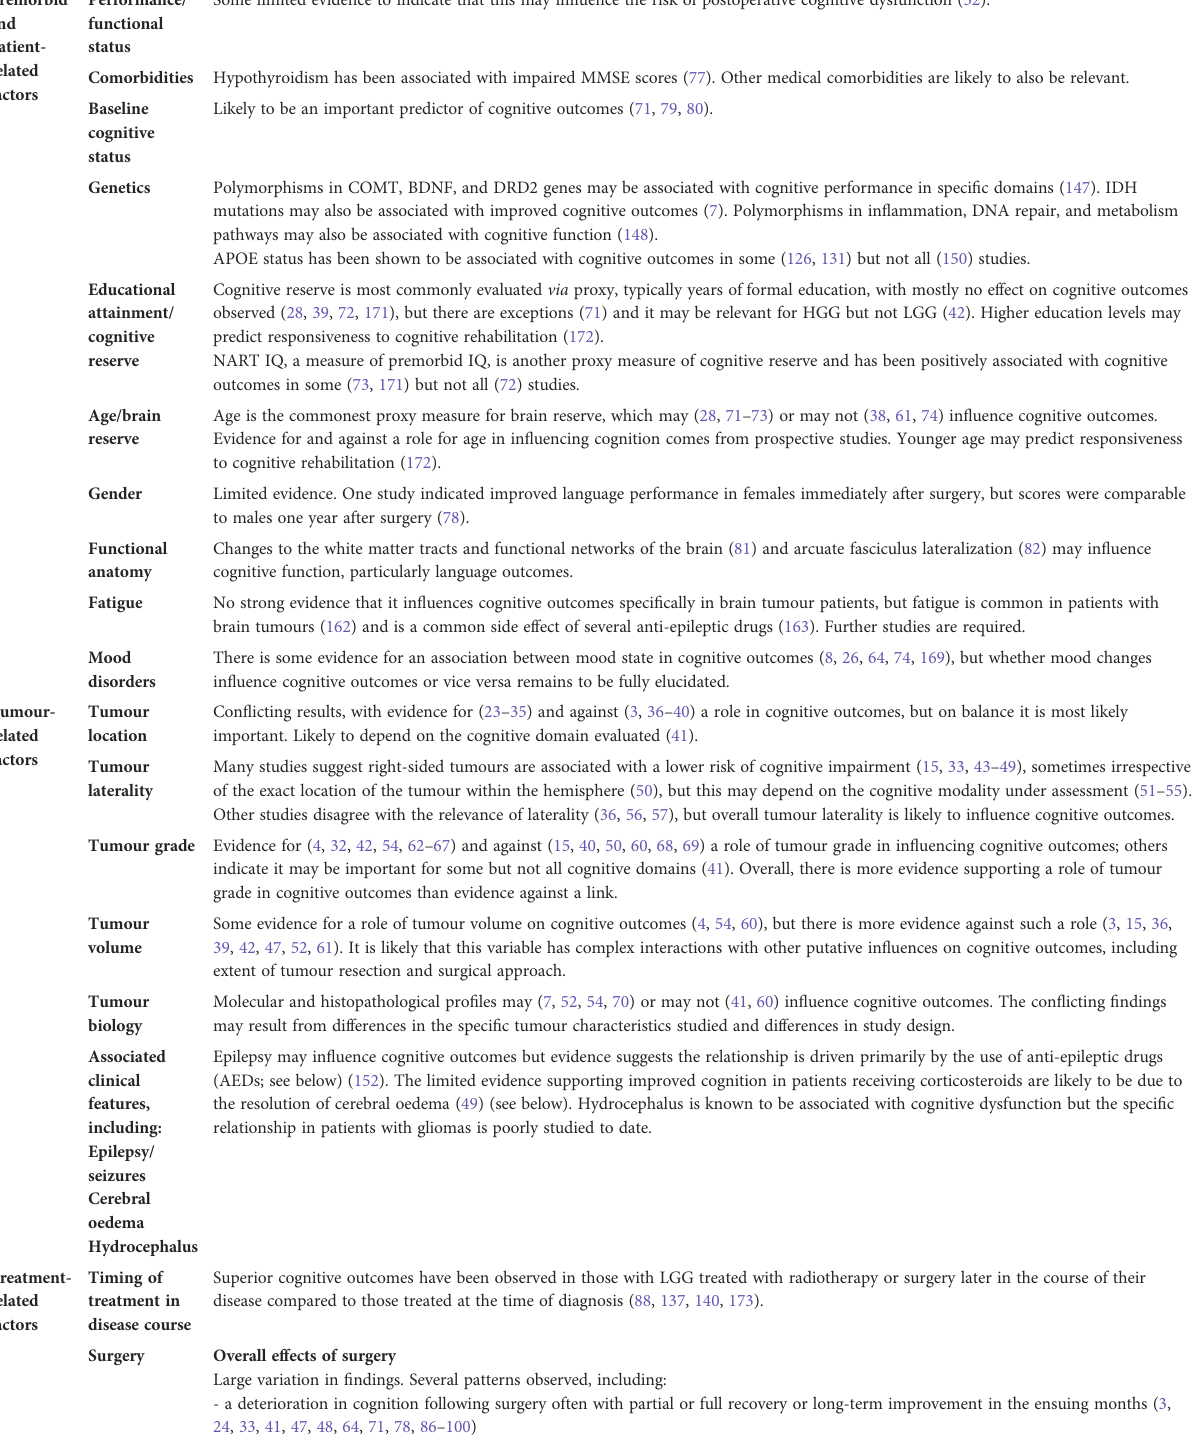
TABLE 2 A summary of the putative in fl uences on cognitive outcomes in patients with gliomas. Factor Evidence/Key Points Premorbid and patient-